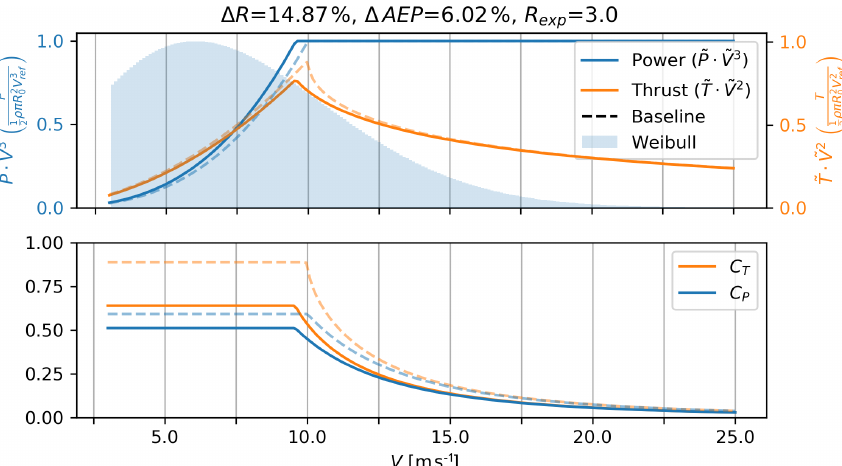
Figure 7. Power and thrust curves for a low-induction rotor (solid lines), designed using the present method with the DDLC exponent R exp = 3, which corresponds to an M flap constraint. The dashed line is the baseline rotor optimized for a max C P